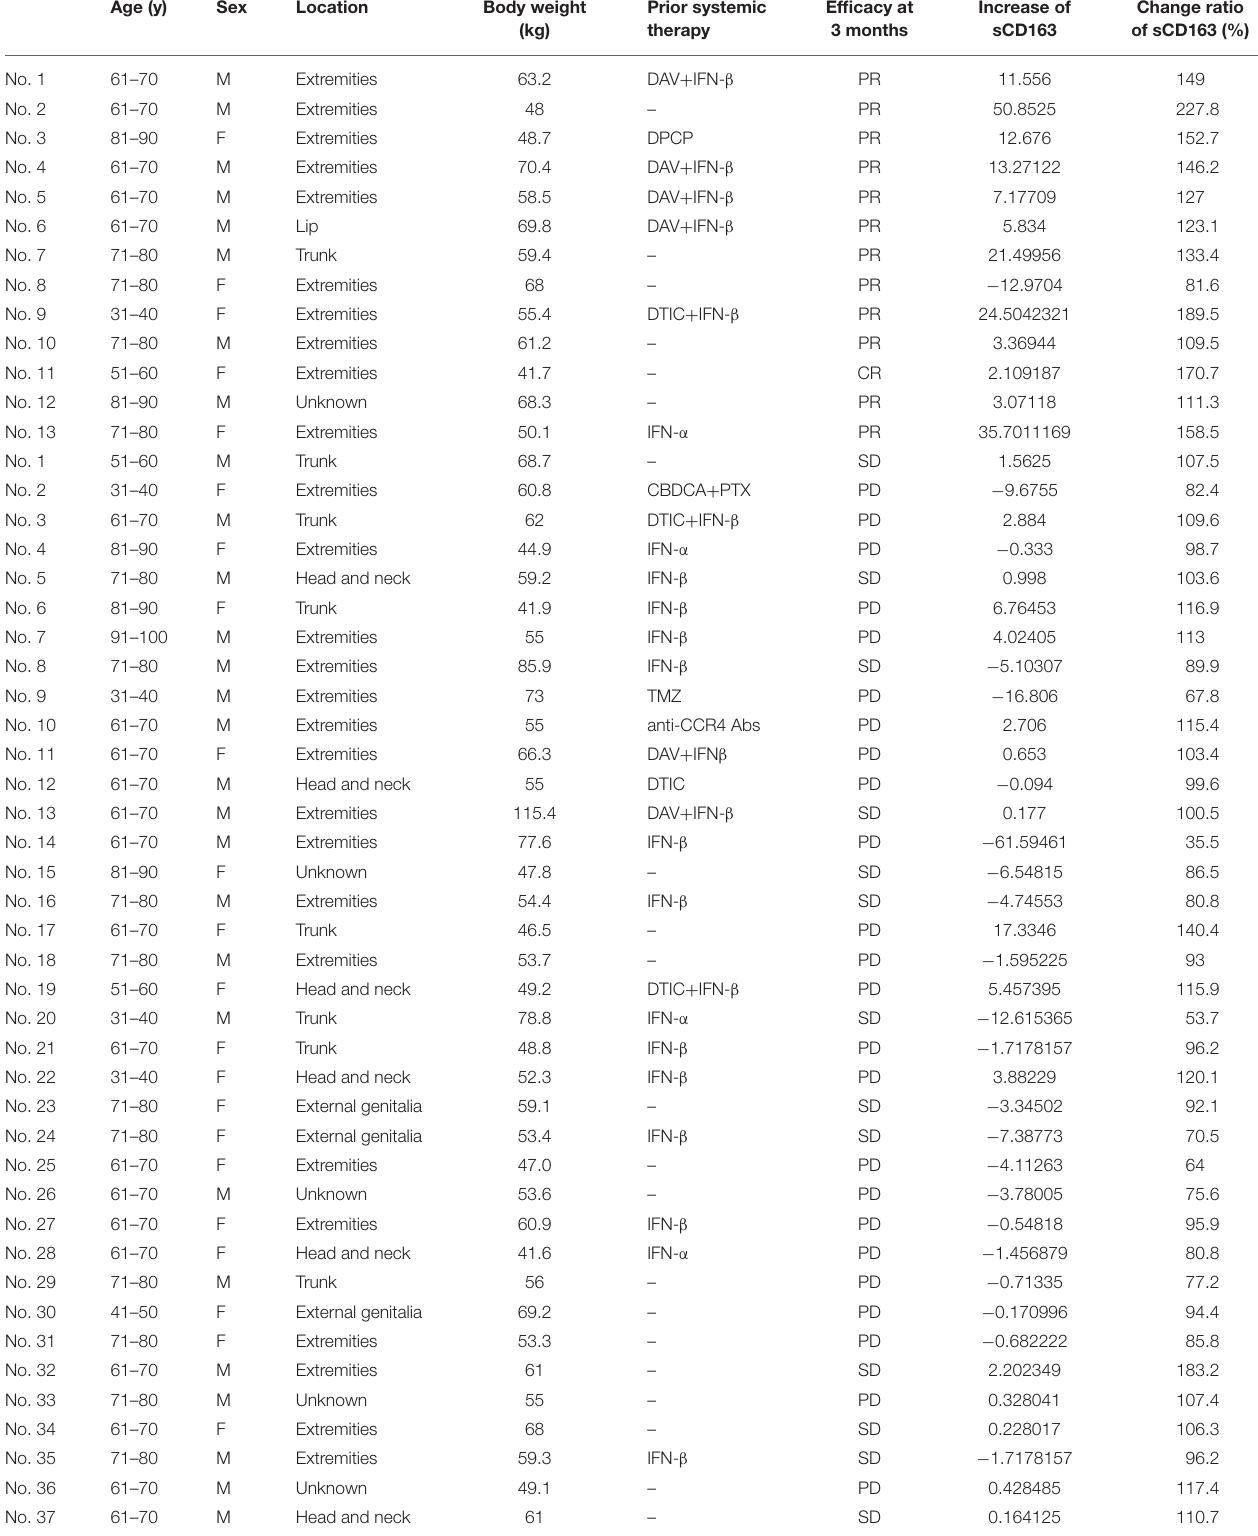
TABLE 1 | Characteristics and serum levels of sCD163 in patients with cutaneous melanoma. Age (y) Sex Location Body weight